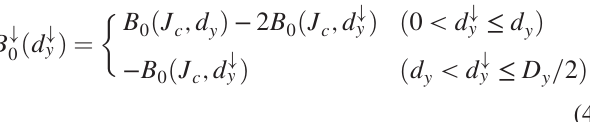
FIG. 3. Three-dimensional model of bulk